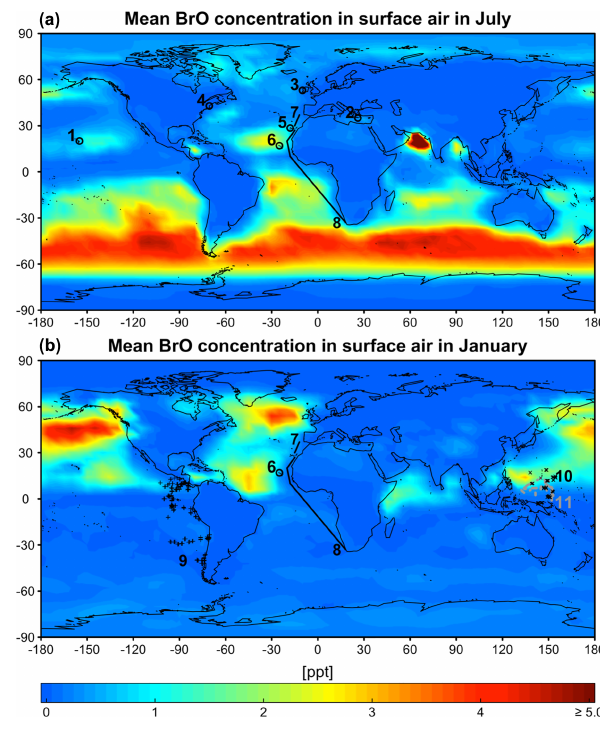
Figure 6. GEOS-Chem mean BrO mixing ratios in surface air in July (a) and January (b) . Locations of BrO observations in Ta- ble 1 are shown as symbols for the closest season. Open circles are ground sites and solid lines are ship tracks. Flight tracks in the marine boundary layer ( < 2km) during the TORERO (Volkamer et al., 2015; Wang et al., 2015; Dix et al., 2016), CONTRAST (Chen et al., 2016), and CAST (Le Breton et al., 2017) aircraft campaigns are shown as pluses, crosses, and dots (gray), respectively. Daytime BrO mixing ratios are about double the values shown here since BrO drops to near zero at night. Color bar saturates at 13.3ppt near